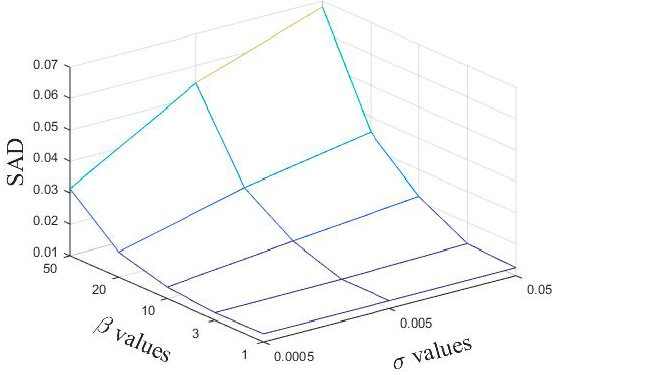
μ in terms of SAD and RMSE.